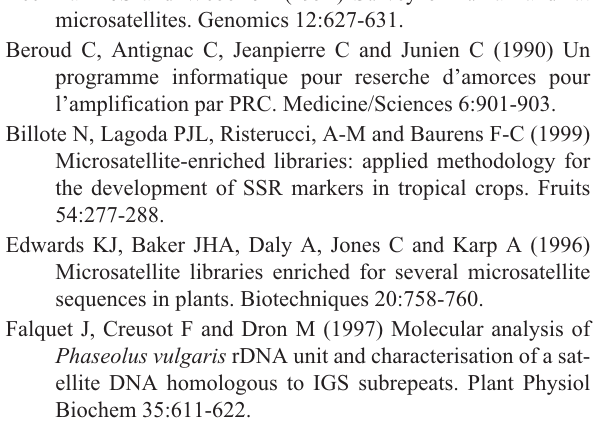
Figure 4 - An un-rooted phylogenetic tree of the MADS-box DNA se- quences of Arabidopsis and the common bean sequence (PVMADS) con- structed using the Kimura two-parameters. Sequence members of the AGL2 subfamily are in bold. Bar indicates